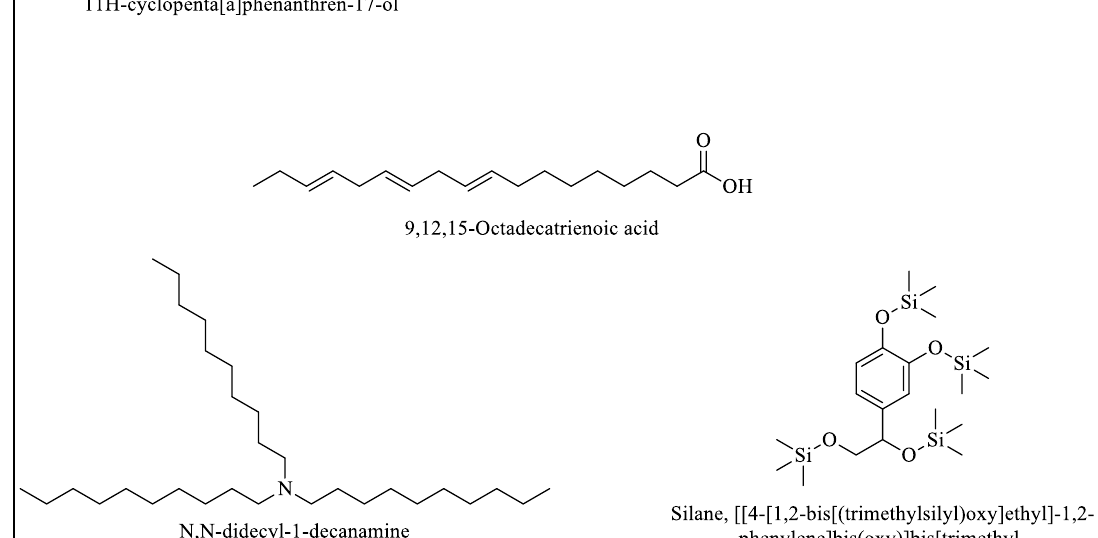
Figure 2. Chemical species identified by GC-MS in the CH 3 COOC 2 H 5 , aqueous, and ethanolic ex- tracts of the stem, root, leaf, and flower at various retention times.